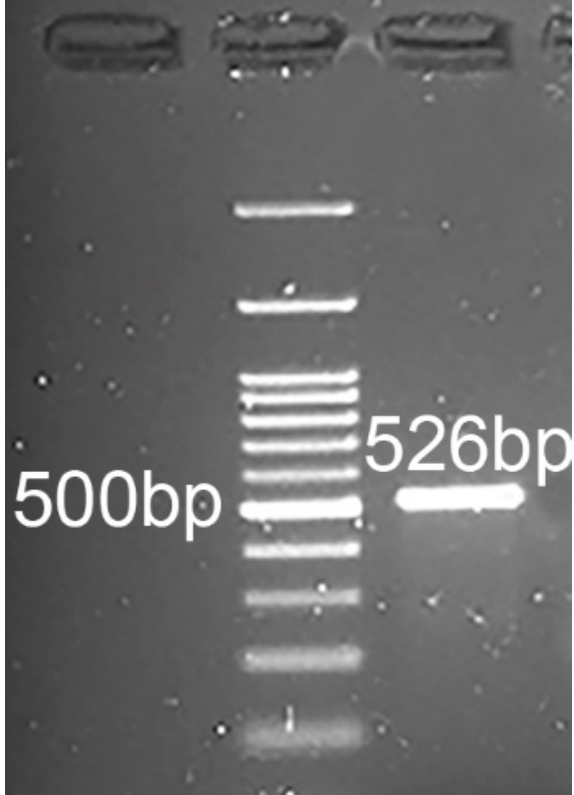
Figure 6. Genomic amplification of the Felis catus transferrin receptor gene ( TFRC ). RT-PCR analysis for TFRC . The amplified fragment size was 526 bp, as expected.